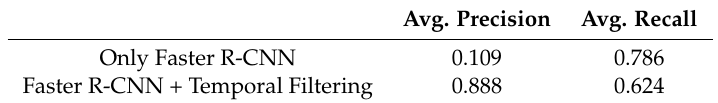
Table 5. The quantitative comparison for the AFT videos in terms of the precision and